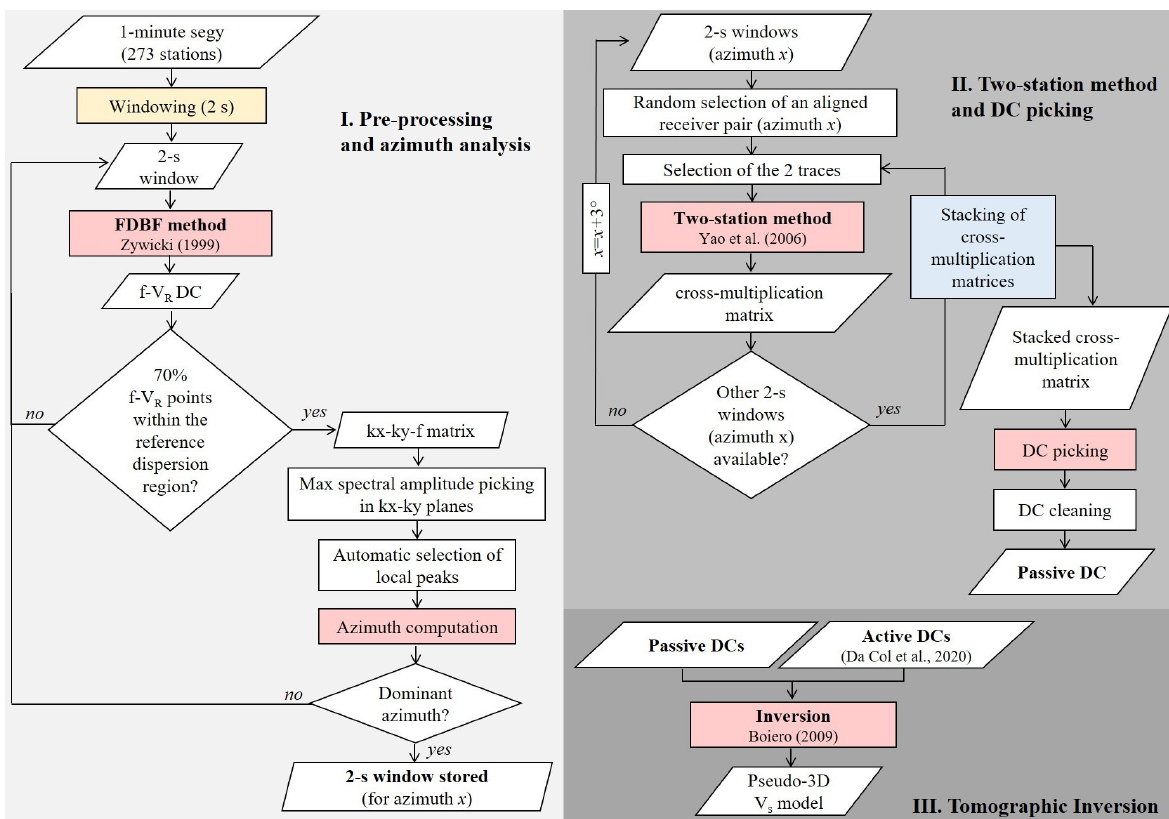
Figure 2. Passive surface wave tomography workflow adopted in this